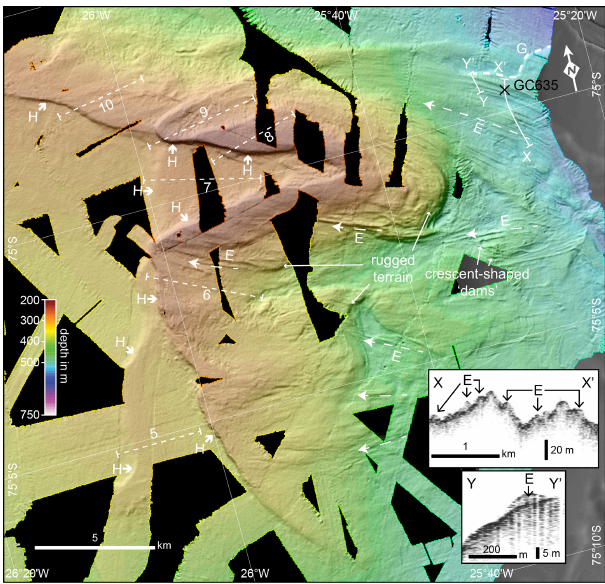
Figure 4. High-resolution bathymetric map from the easternmost part of McDonald Bank showing parallel ridges squeezed by and smeared at the base of grounding ice slabs enclosed in perennial sea ice (long dashed arrows, Class E) and wedge-shaped ramps (fronts marked by short bold arrows, Class H). Note the more rugged ter- rain inshore of the ramps that may reflect outcrops of a mafic in- trusion. The bold dashed line marks the front of the innermost grounding-zone wedge (GZW; Class G). The thin dashed numbered lines indicate locations of ramp profiles shown in Fig. 5. Inset fig- ures shows acoustic sub-bottom profiles across Class E